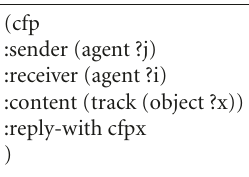
“tracking,” and “f(x)” should be determined by the receiving agent. In normal usage, the agent responding to a cfp should answer with a proposition giving the value of the precondi- tion expression. An example of this message would